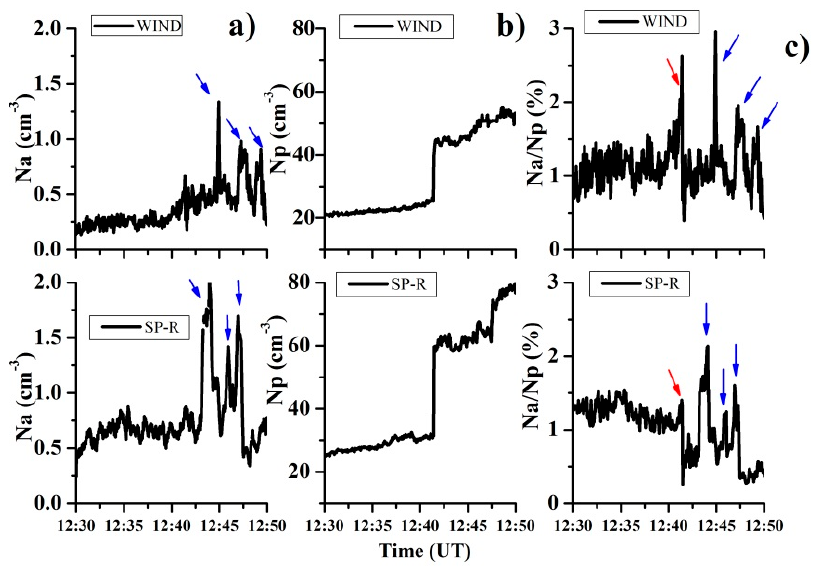
Figure 2. Changes in the time profiles of the proton and He ++ ion densities according to data from the SPEKTR-R and WIND satellites for the event of 9 September 2011: (column ( a )) absolute He ++ ion density; (column ( b )) absolute proton density; (column ( c )) relative He ++ ion density. Satellites’ coordinates (GSE coordinate system, Re): Spektr-R (10,25; − 30,94; 19,12); WIND (207,42; 84,96; − 10,49).